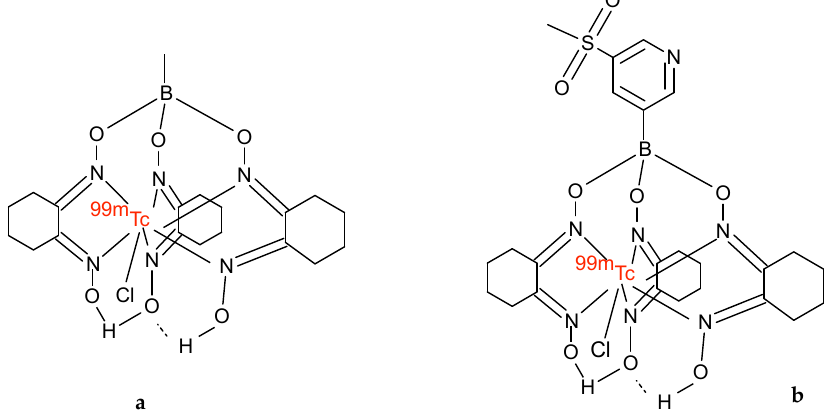
Figure 2. Chemical structure of ( a ) [ 99m Tc]Tc-Teboroxime, ( b ) [ 99m Tc]Tc-3SPboroxime. After intravenous administration, the myocardial absorption of [ 99m Tc]Tc-Teborox-